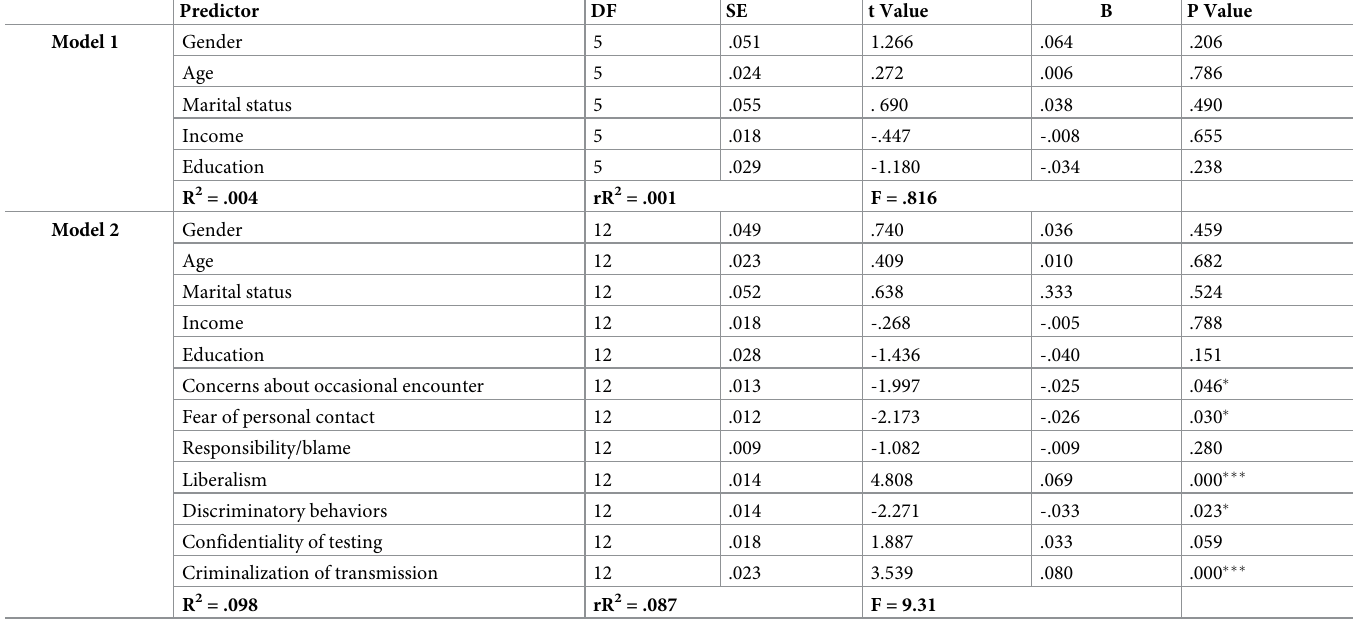
Table 4. Predictors of COVID-19 intention for testing (N = 1,074).